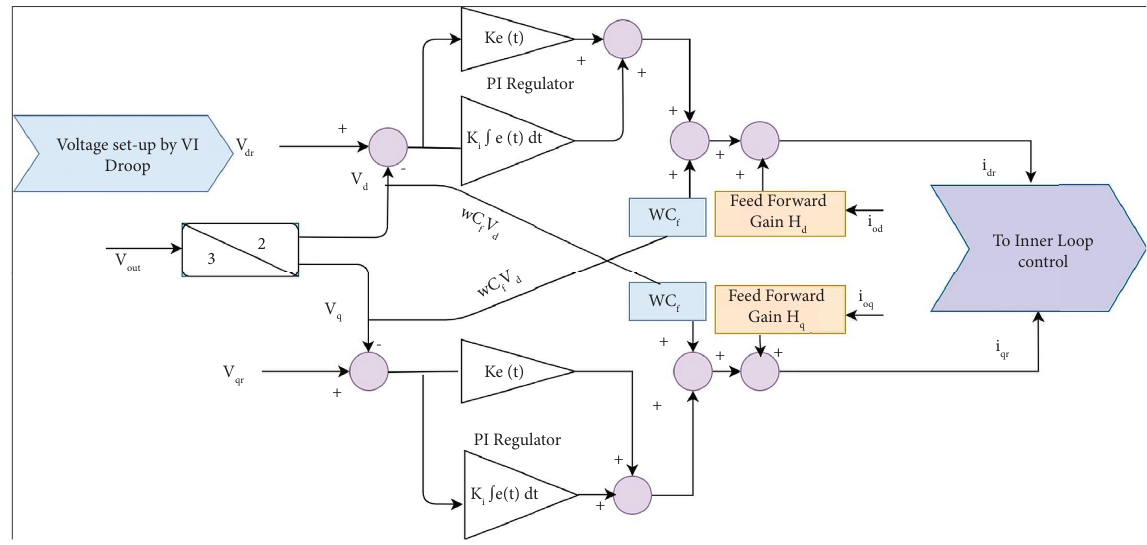
Figure 5: Design of outer controller loop.